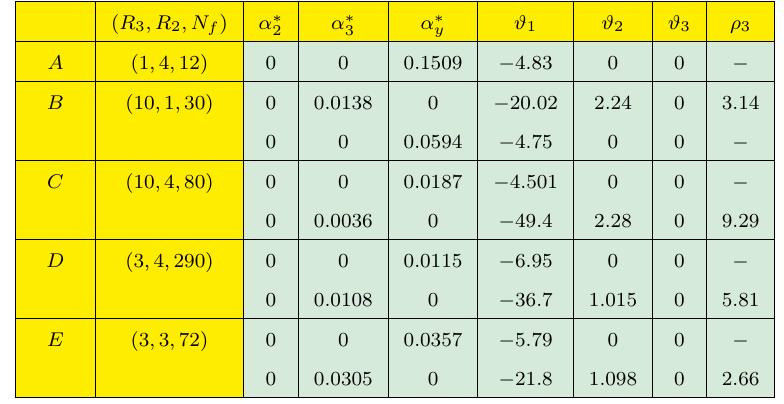
for the benchmark models in [15] for the 321 3